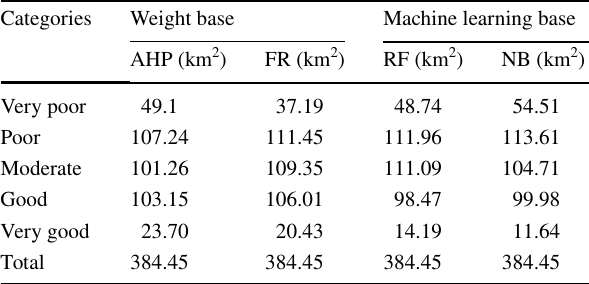
Table 7 Area under groundwater potential zones of different models Categories